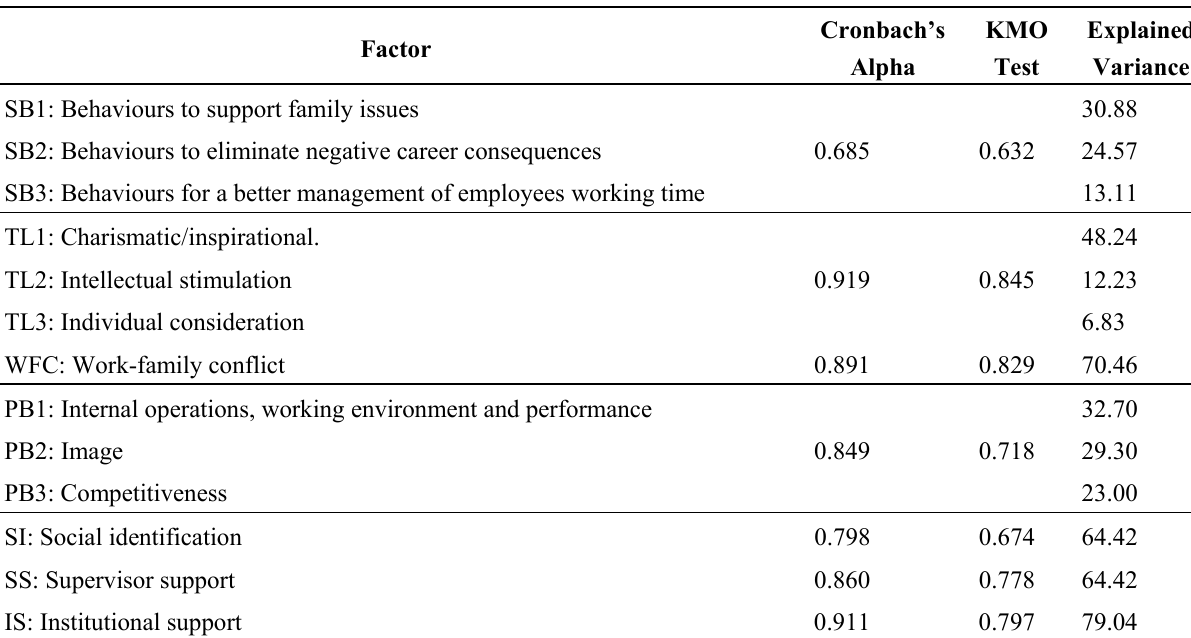
Table 1. Reliability of scales, constructs’ internal consistency and dimensions of dependent and independent variables.